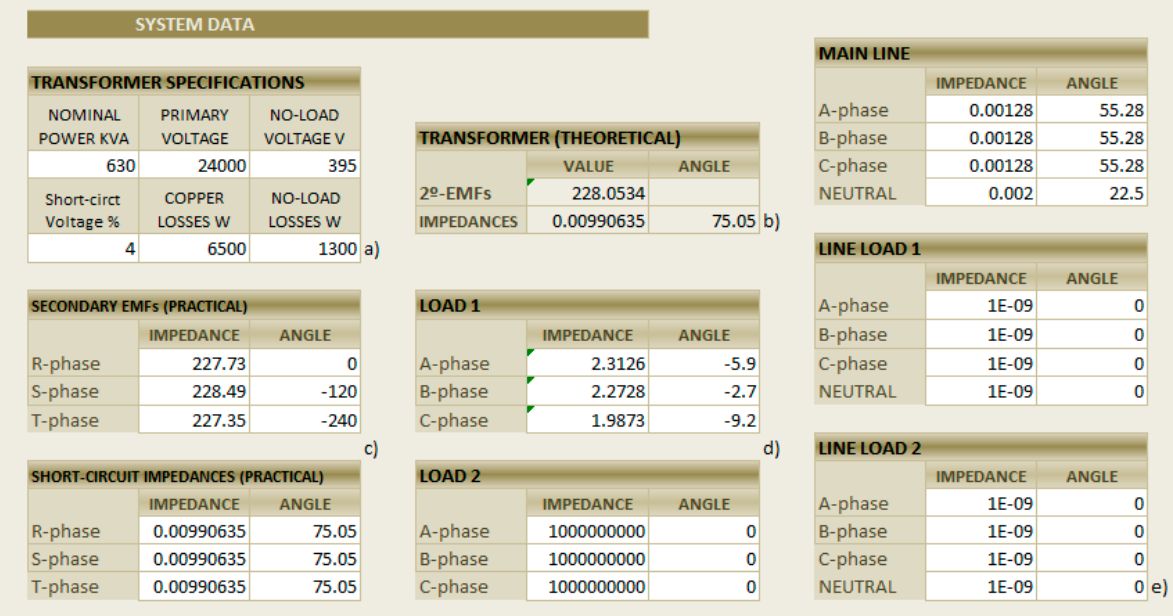
Figure 10. “System data” screen after entering transformer, line, and load data; ( a ) transformer fea- tures; ( b ) theoretical values of transformer secondary EMFs and short-circuit impedances; ( c ) practical values of secondary EMFs and short-circuit impedances; ( d ) load impedances; and ( e ) line and neutral conductor impedances.